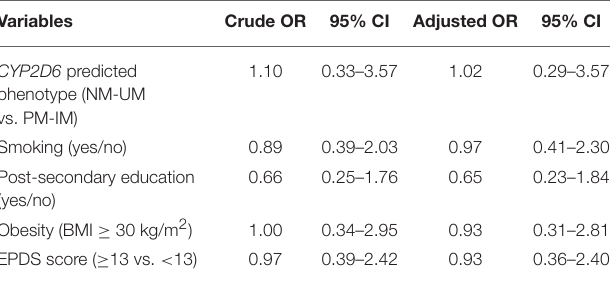
TABLE 4 | Genotype-predicted CYP2D6 phenotype and the risk of antidepressant dosage modification during pregnancy.